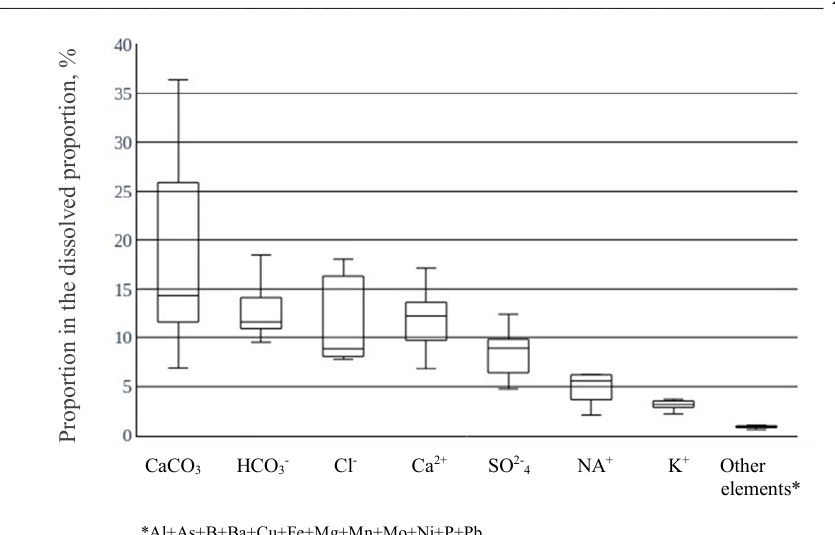
Fig. 3 Composition of the part of biochar dissolved as a result of washing.